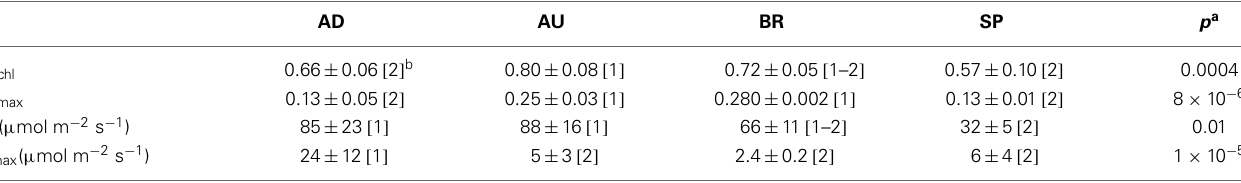
Table 2 | Average values and standard deviations of the physiological parameters characterizing the mats from the different sites. AD